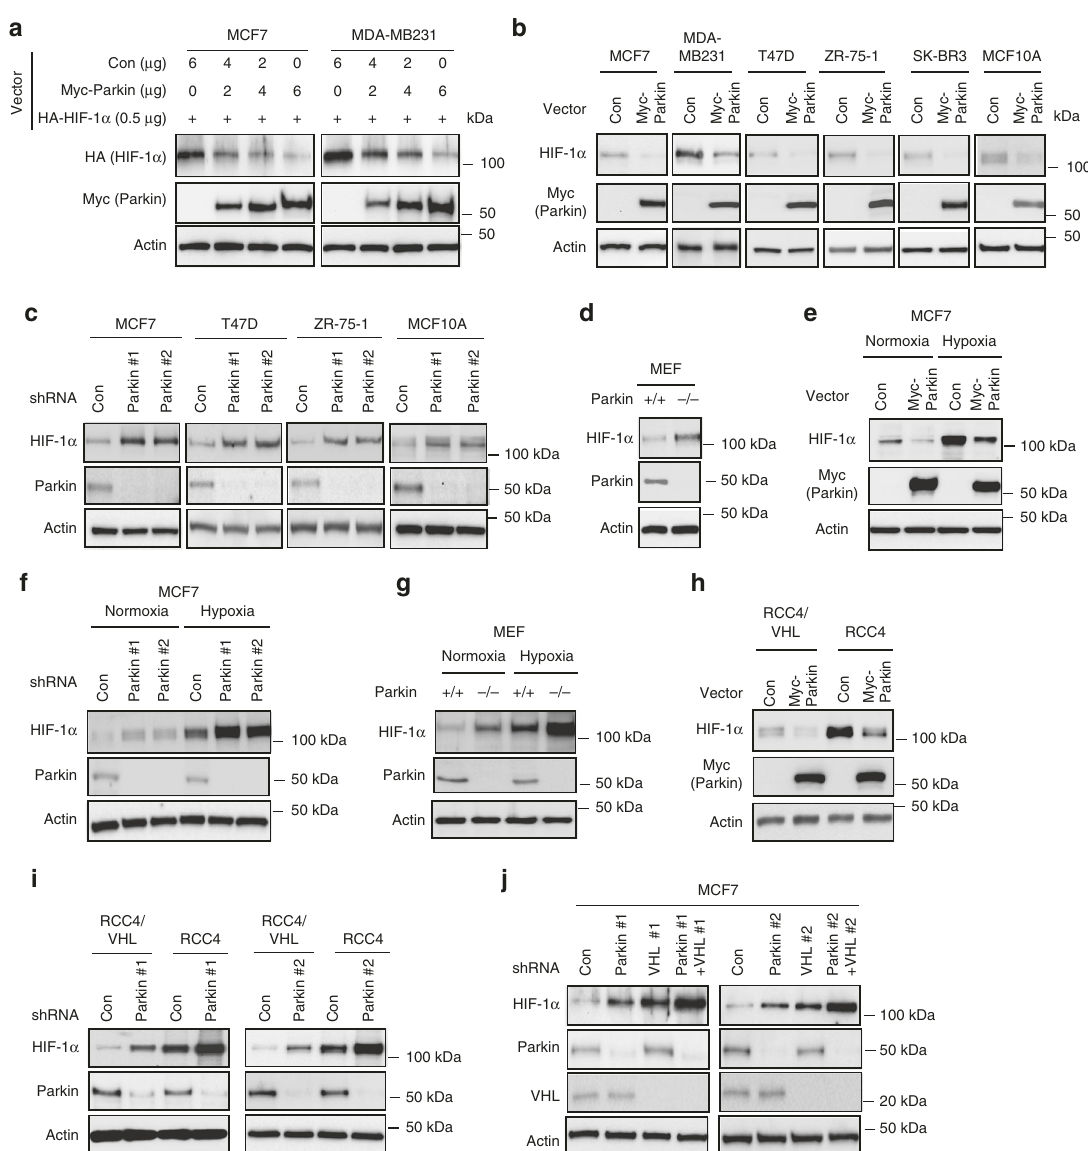
is required for Parkin to interact with HIF-1 α . We further mapped the domain of HIF-1 α that interacts with Parkin by co-transfecting Myc-Parkin vectors and vectors expressing different HA-tagged deletion mutants of HIF-1 α into MCF7 cells using co-IP assays. As shown in Fig. 1g, the ID domain (Inhibitory domain) of HIF-1 α is required for HIF-1 α to interact with Parkin. To further investigate whether Parkin interacts with HIF-1 α , in vitro GST and His pull-down assays were performed using GST- Parkin and His-Trx-HIF-1 α proteins puri fi ed from bacteria. The